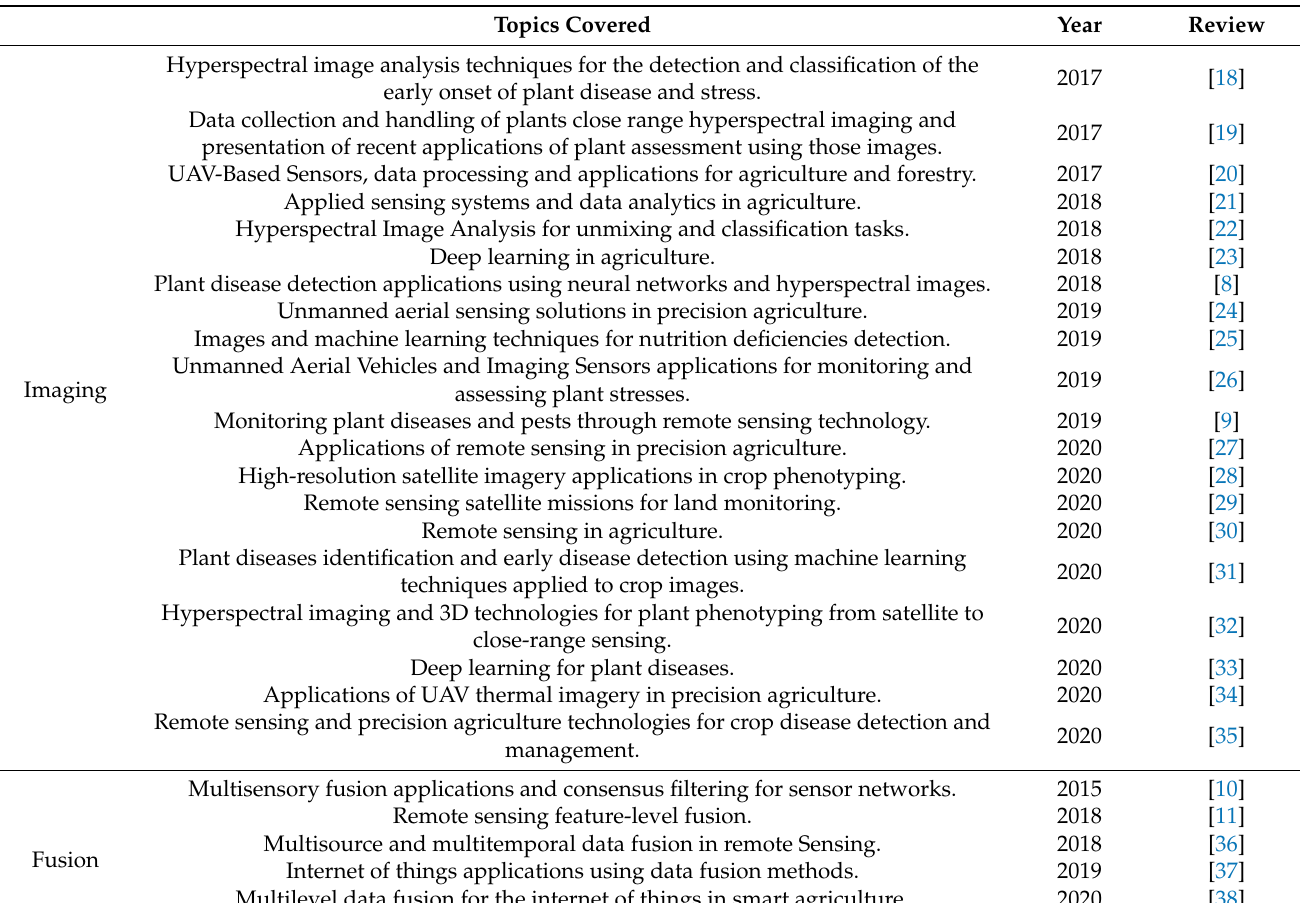
Table 1. Cont. Topics